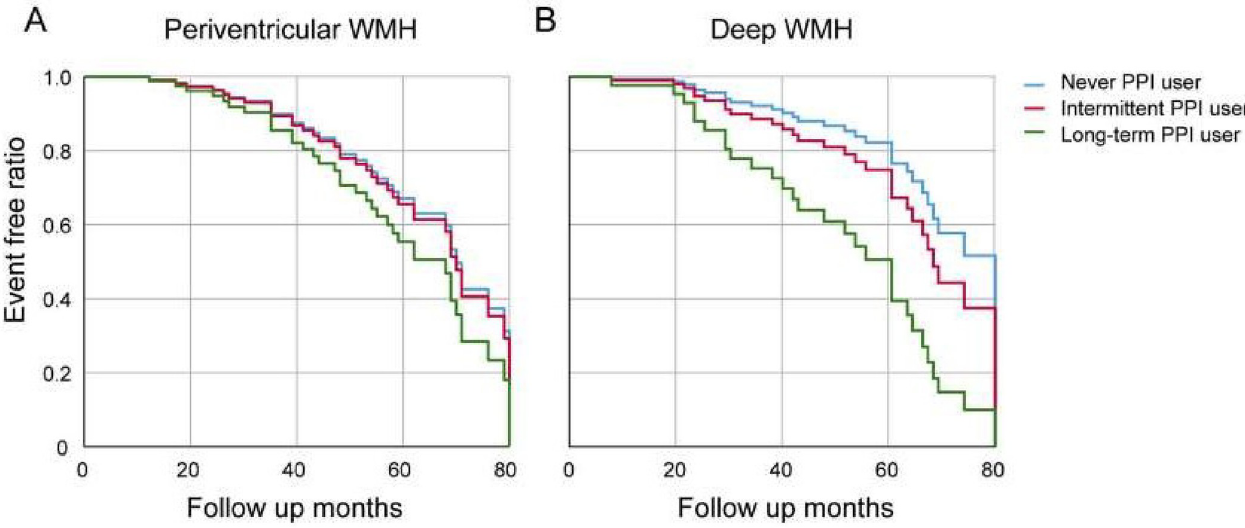
Fig 1. Multivariate Cox regression for progression of Fazekas score of white matter hyperintensity with the time since baseline as a dependent variable with proton pump inhibitor dose. The progression of periventricular WMH was not different among PPI never users, intermittent users, or long-term users (A). However, long-term PPI users had more progression of deep WMH compared to PPI intermittent users or PPI never users. Adjusted covariates were age, history of hypertension, diabetes, dyslipidemia, previous stroke or transient ischemic attack, coronary heart disease, and use of antiplatelet agents. Abbreviations: WMH, white matter hyperintensities; PPI, proton pump inhibitor.